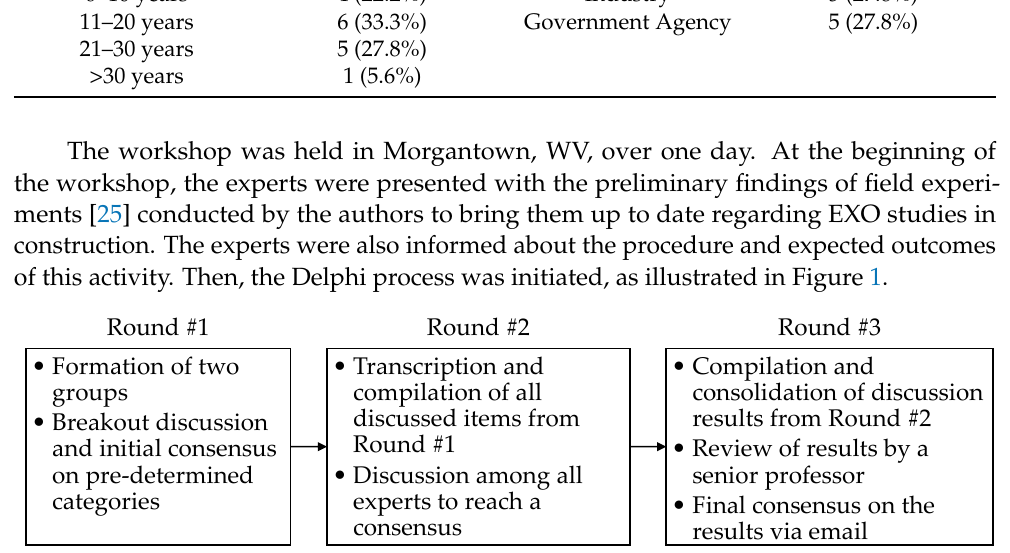
Figure 1. Schematic diagram of the three-phase Delphi process.